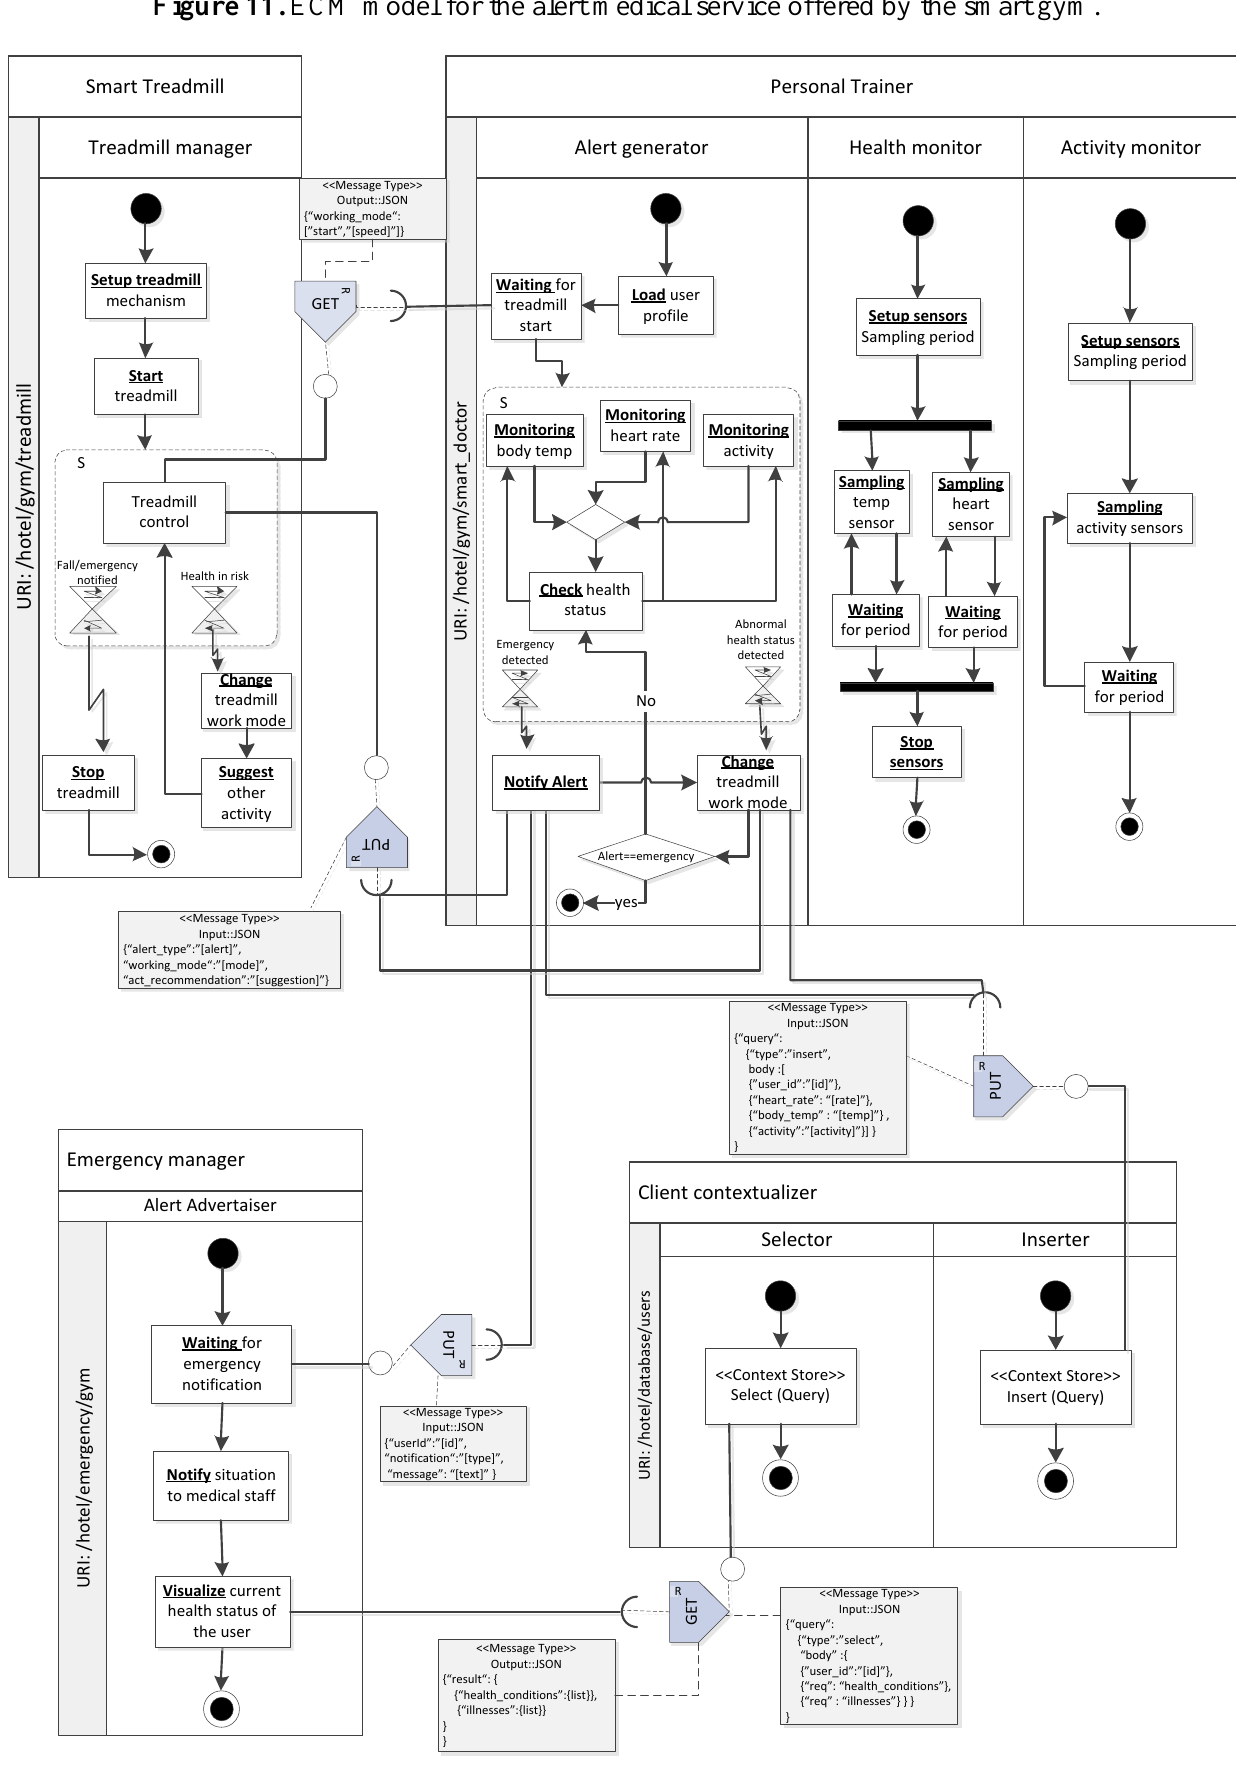
Figure 11. ECM model for the alert medical service offered by the smart